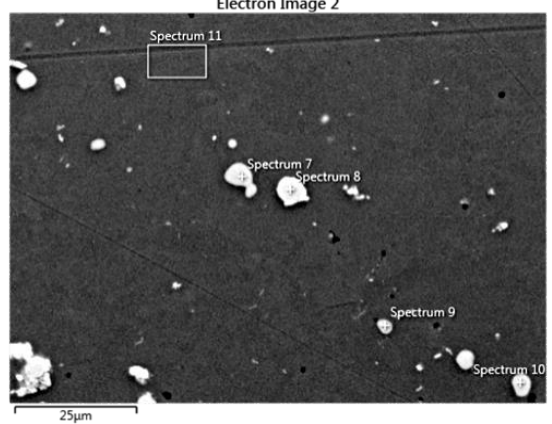
Figure 6. AA7050 alloy zone analyzed using SEM-FEG + EDS point detection. Table 5. SEM-FEG EDS chemical analysis results (%